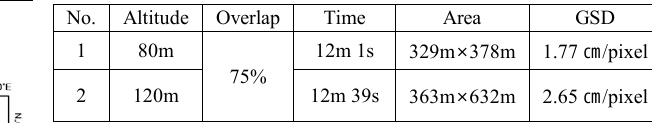
Table 3 . Results of UAV aerial surveying